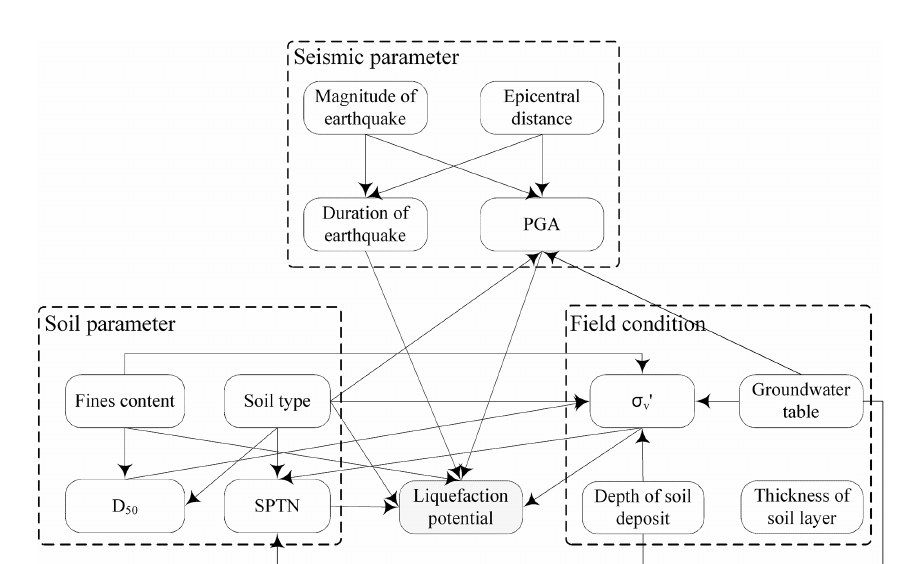
Figure 3. A BN model of seismic liquefaction (Hu et al.,